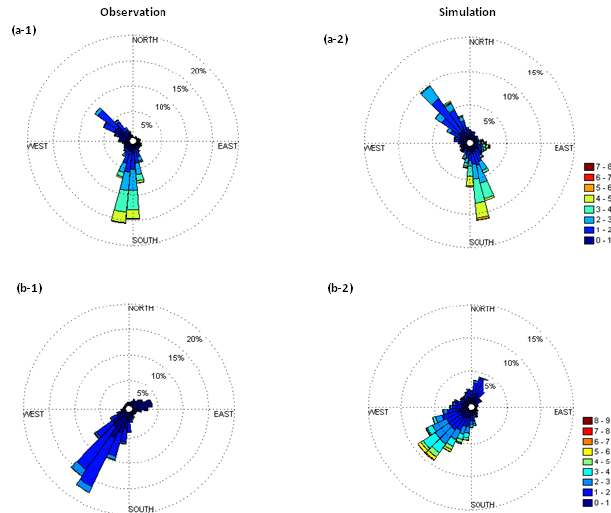
Fig. 3. Wind rose plots comparing observed (left column) and simulated (right column) winds during March - June 2010 at UC Riverside (33.96ºN, 117.33ºW) (top) and Pomona (34.05ºN, 117.81ºW) (bottom).